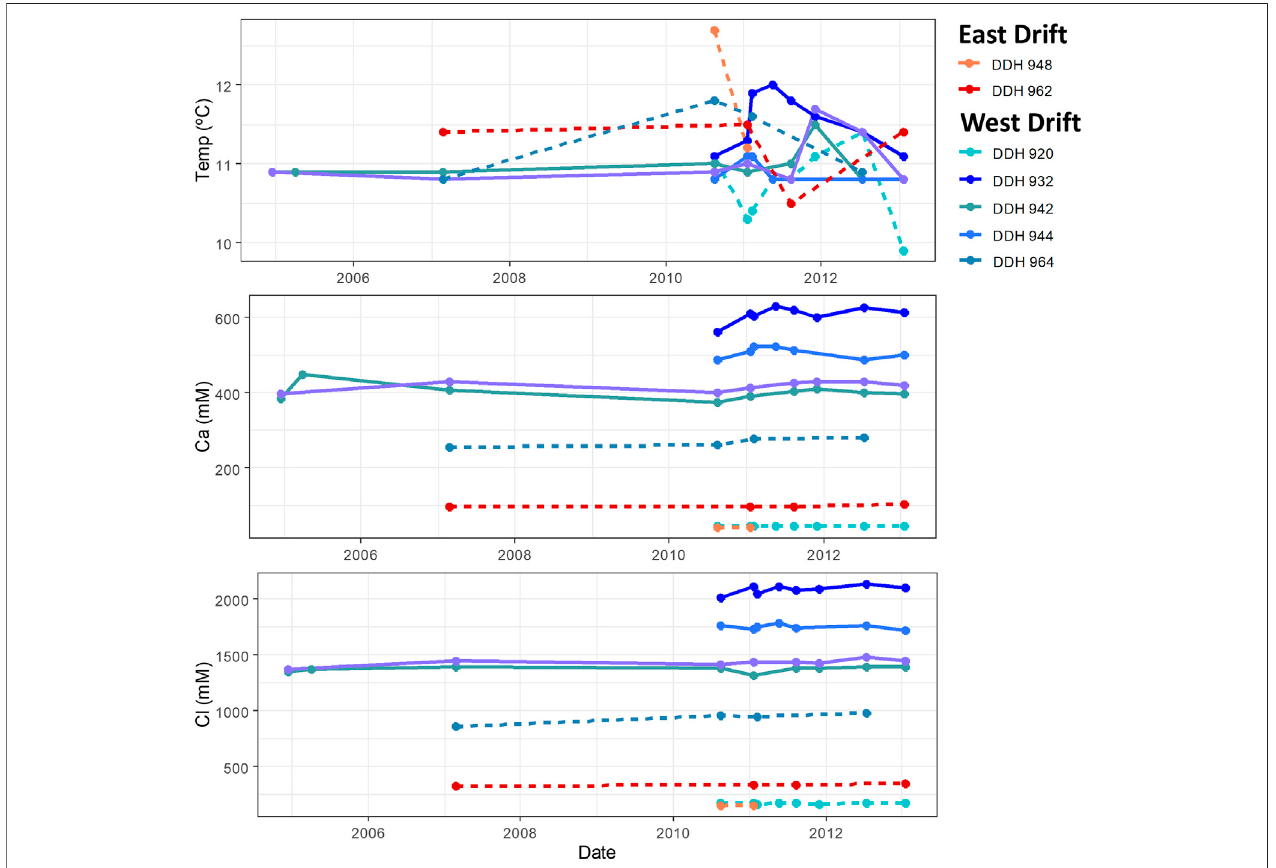
FIGURE 2 | Stability of the temperature and major iron concentrations in Soudan boreholes. East drift boreholes are shown in shades of red, while west drift boreholes are shown in shades of blue. Solid lines indicate boreholes drilled at a downward angle, while dashed lines indicate horizontal or upward angled boreholes.